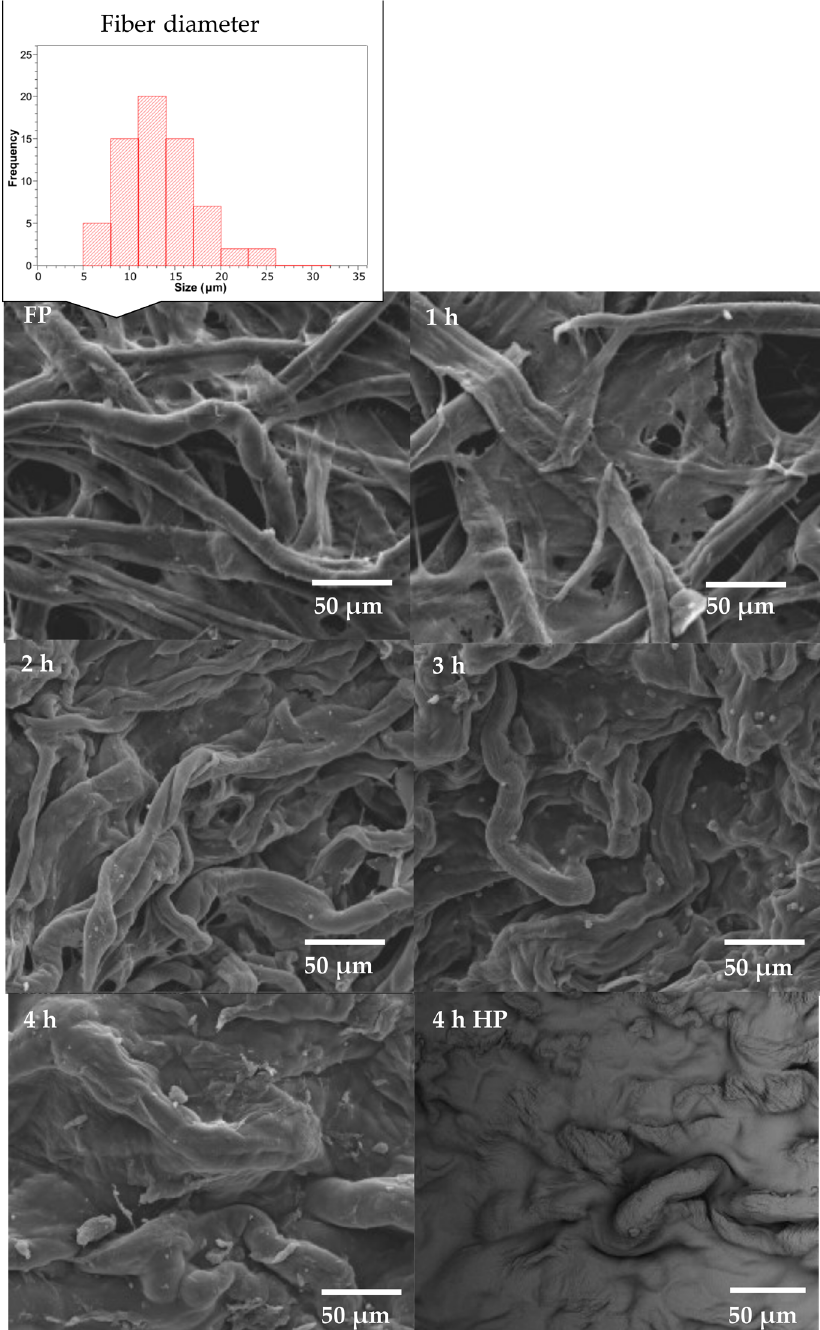
Figure 1. SEM micrographs of filter paper (FP) and ACCs samples treated with 7 wt% NaOH/12 wt% urea for 1, 2, 3, 4 h and 4 h hot pressed